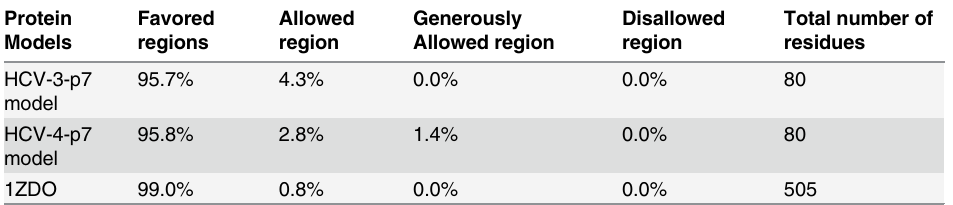
Table 3. Ramachandran plot describing the total number of residues as well as the number of resi- dues located in allowed and disallowed regions for both the modeled p7 protein from HCV GT3 and HCV